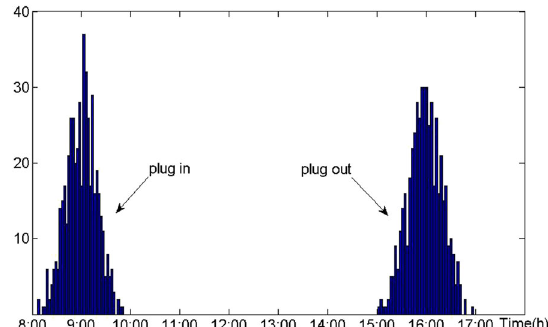
Fig. 9 Random integration and departure of EVs in a charging